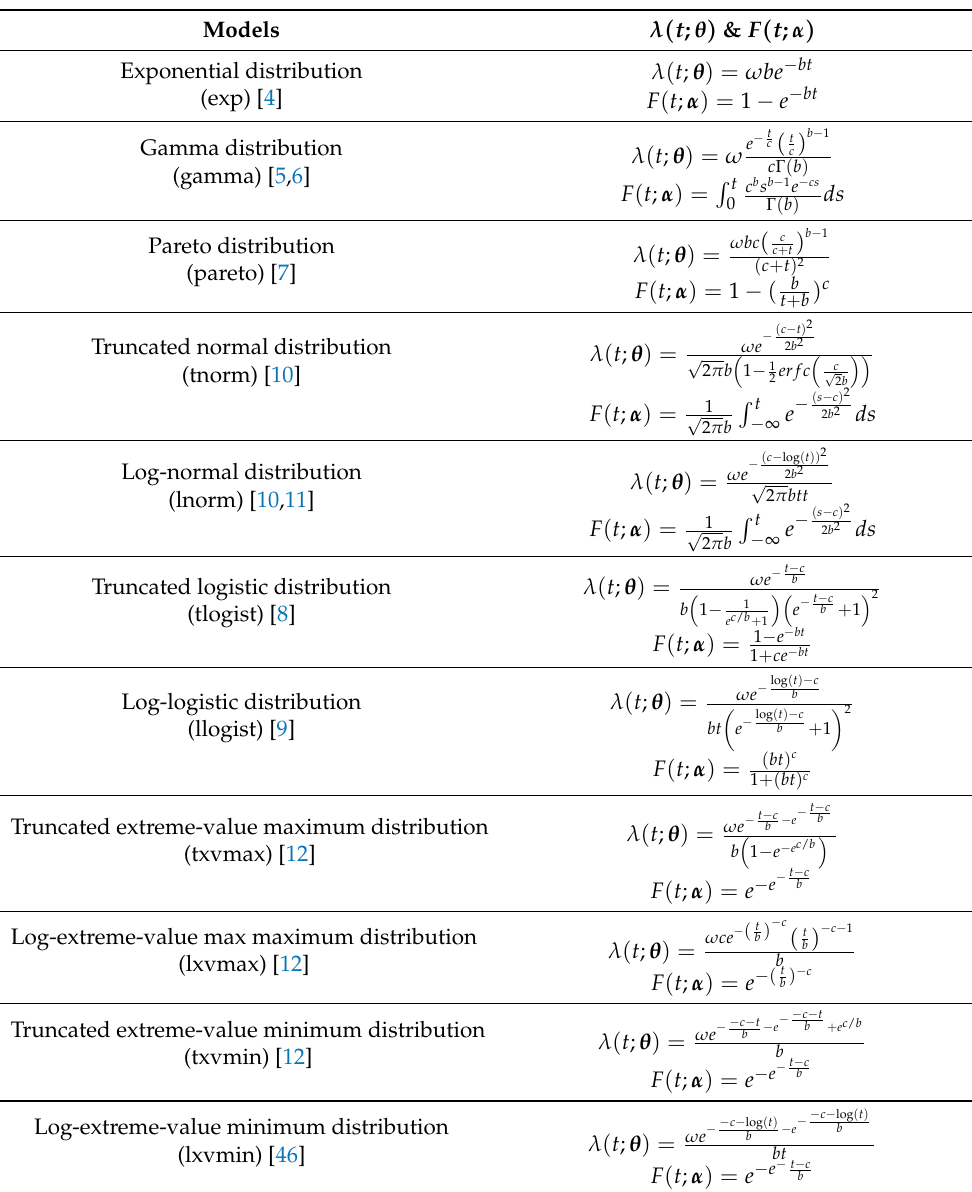
Table 1. The existing NHPP-based